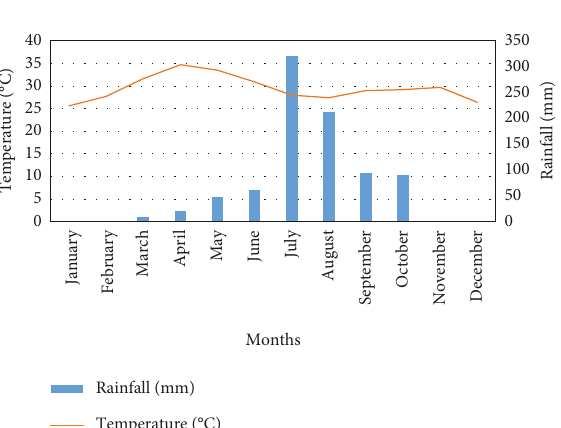
Figure 2: Variation of the monthly average duration of the daily photoperiod